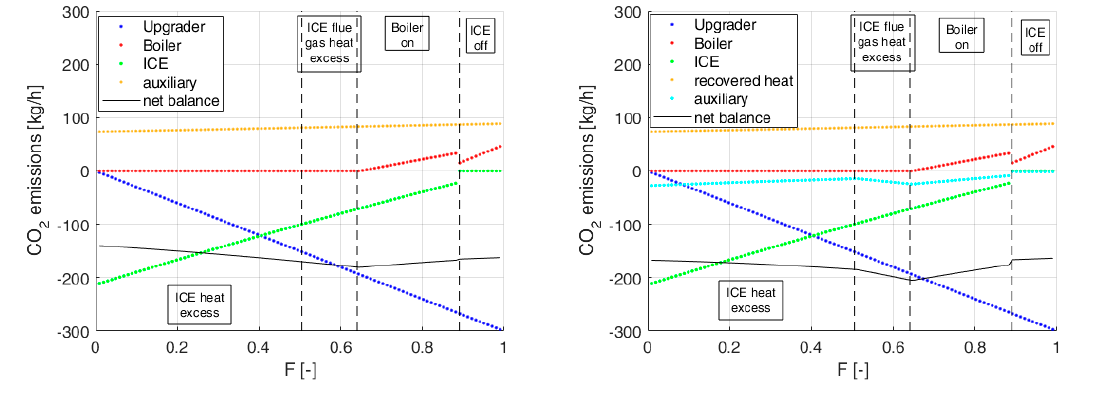
Figure 6. CO 2 balance as a function of F .